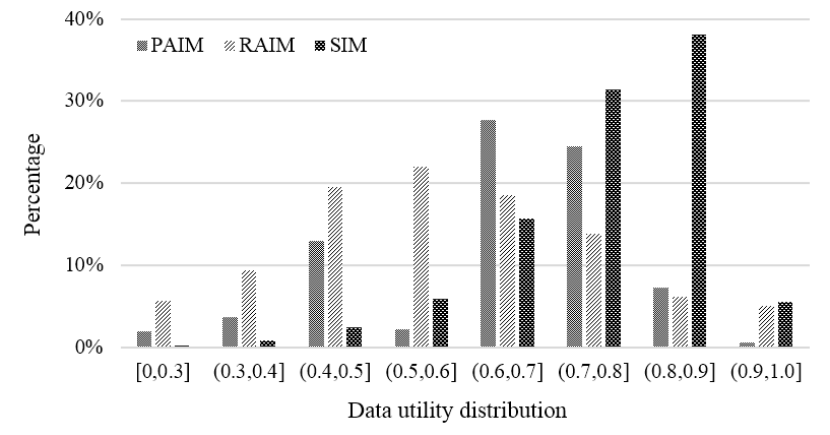
Figure 13. Comparison of data utility